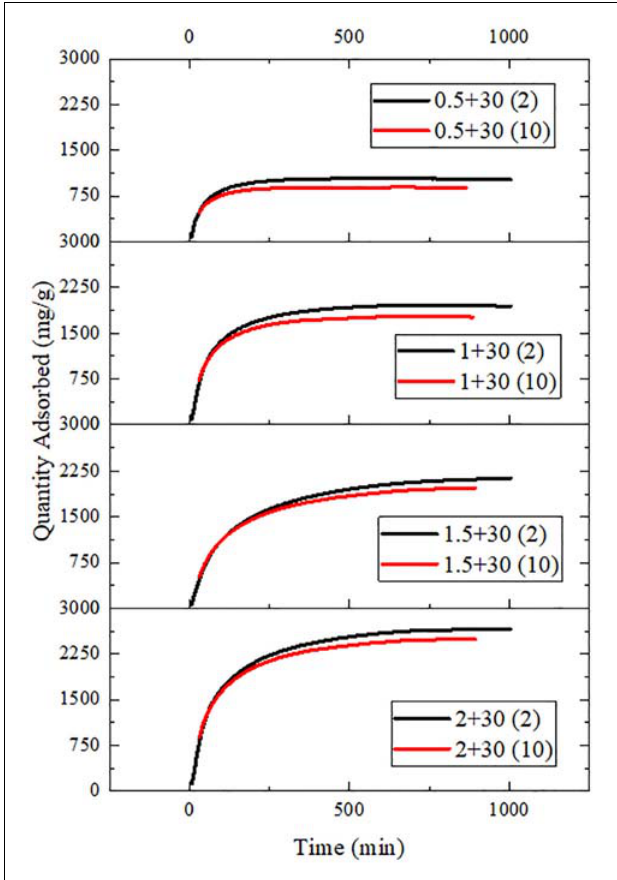
FIGURE 10 | Comparison of adsorption rate of composites in the second and tenth water adsorption